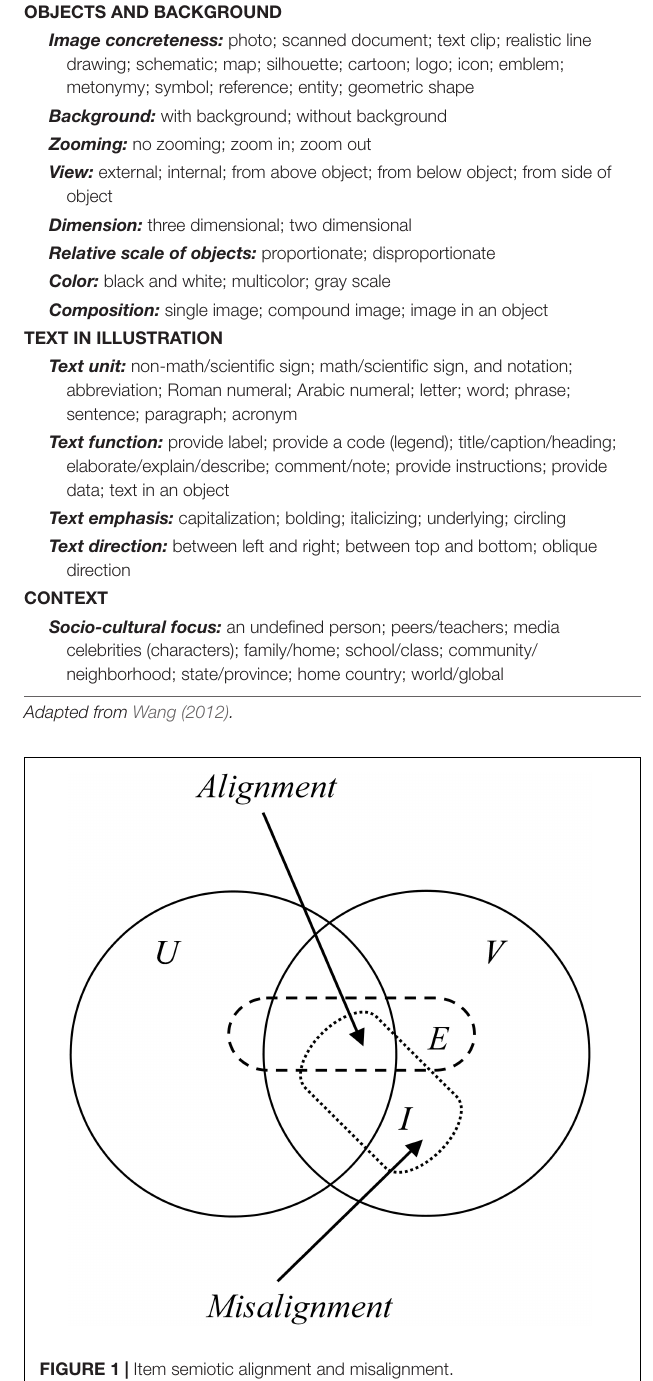
FIGURE 1 | Item semiotic alignment and